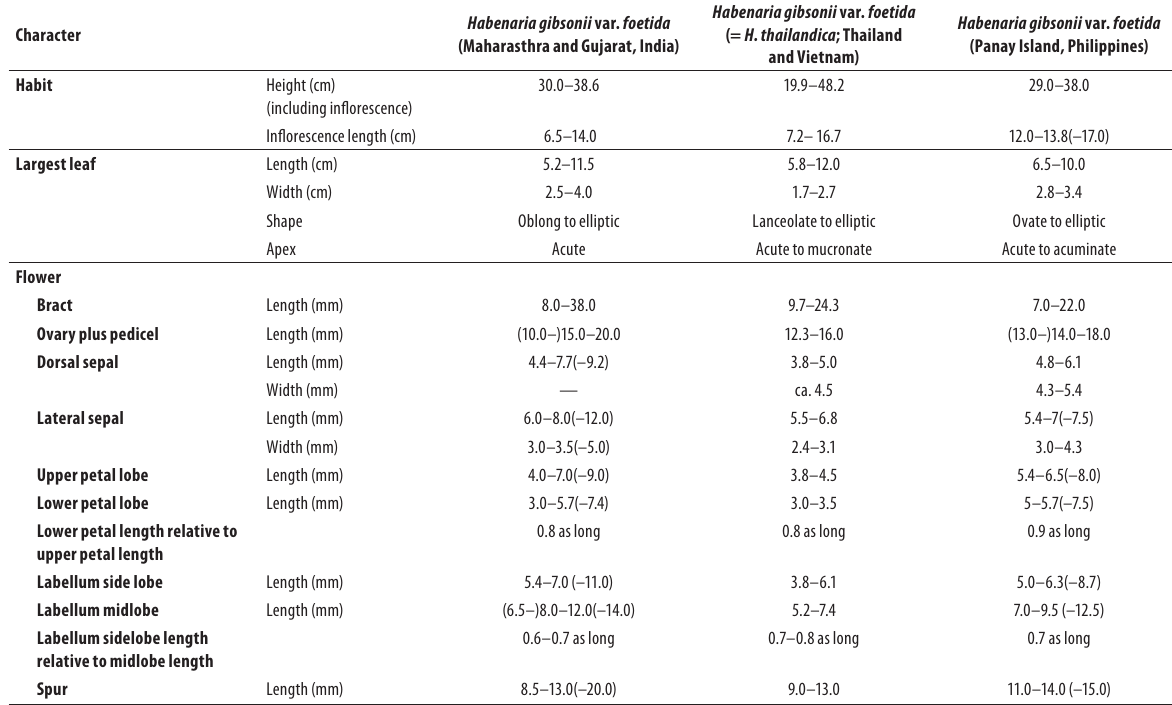
Table 1. Comparisons of Habenaria gibsonii var. foetida Blatt. & McCann from India, Indochina (Thailand and Vietnam), and the